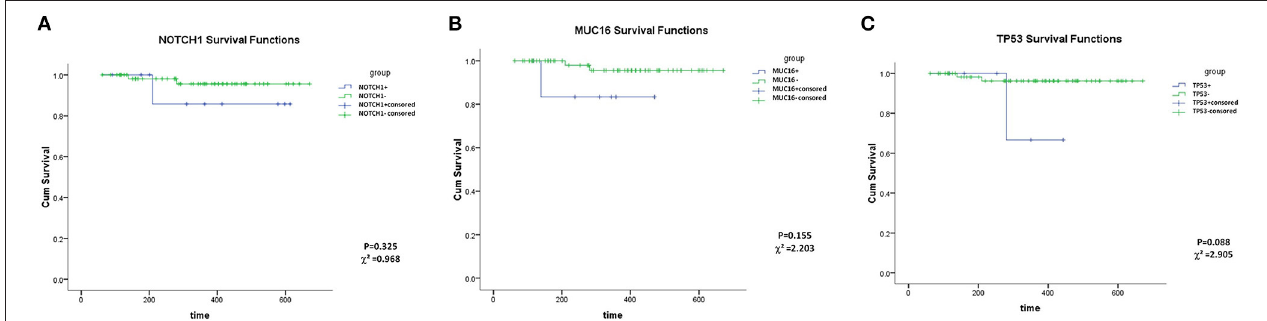
FIGURE 2 | Overall survival analysis of NOTCH1 (A) , MUC16 (B) , TP53 (C)